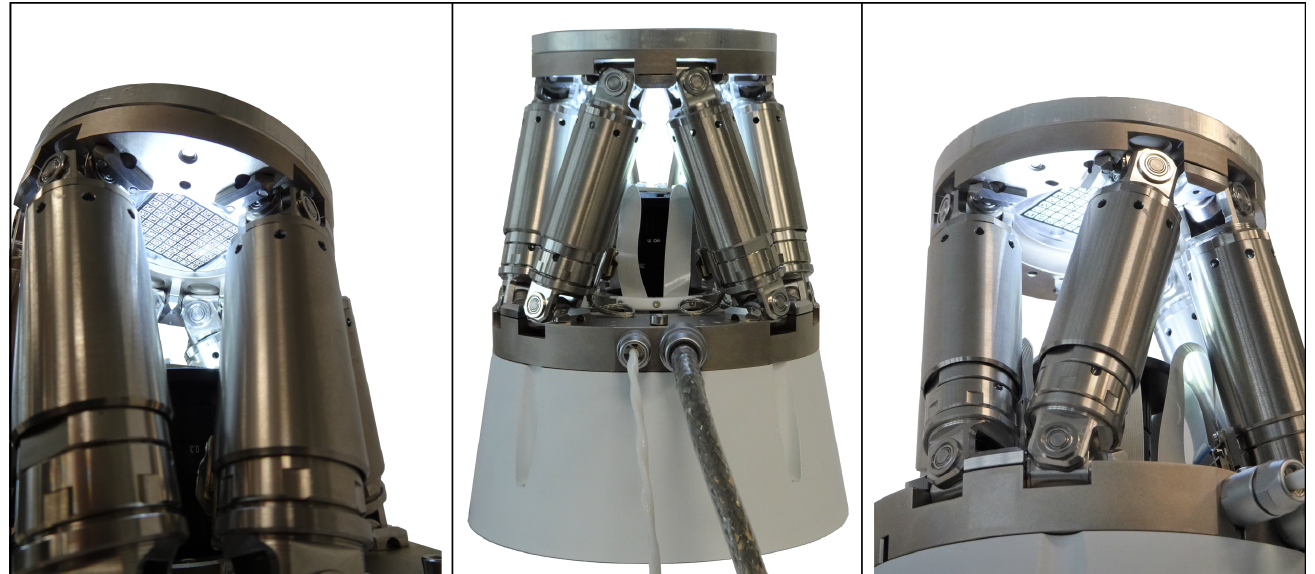
Figure 16. Photography of the investigated hexapod with the implemented vision-based concept for pose